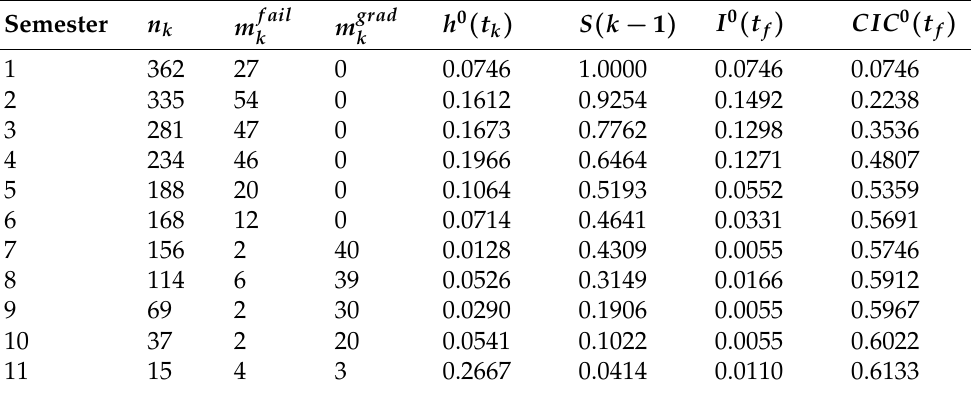
Table 2. Calculation of Cumulative Incidence Curves for dropped out